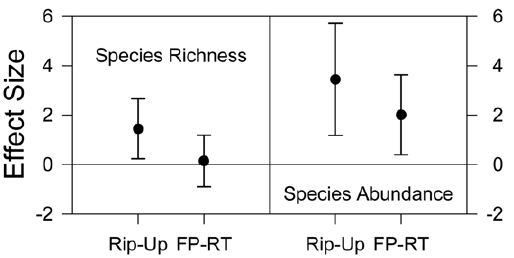
Figure 7. Richness and abundance meta-analysis results. Rip- Up=the difference in richness or abundance between riparian and upland zones; FP-RT=the difference in richness or abundance between river floodplain and river terrace habitat types. Results from the meta- analyses examining the difference in species richness and species abundance between riparian and upland zones (n=8 groups) and between river floodplain and river terrace habitat types (n=11 groups). The figure shows mean weighted effect sizes with associated upper and lower 95% confidence intervals.